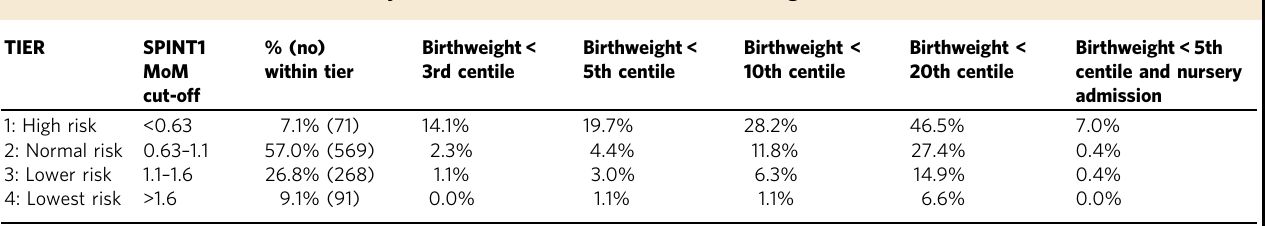
Table 2 Four-tier risk model for delivery of neonates with different low birthweight